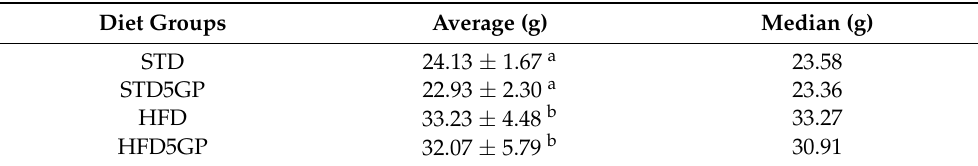
Table 2. Summary of the body weights for the indicated groups of mice after 13 weeks on respective